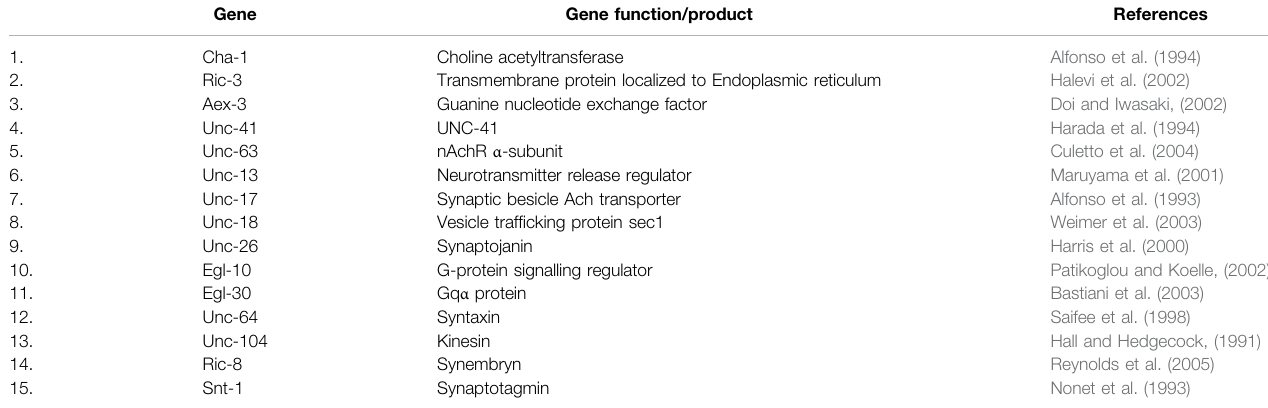
TABLE 1 | Genes exhibiting resistance to aldicarb. Gene Gene function/product